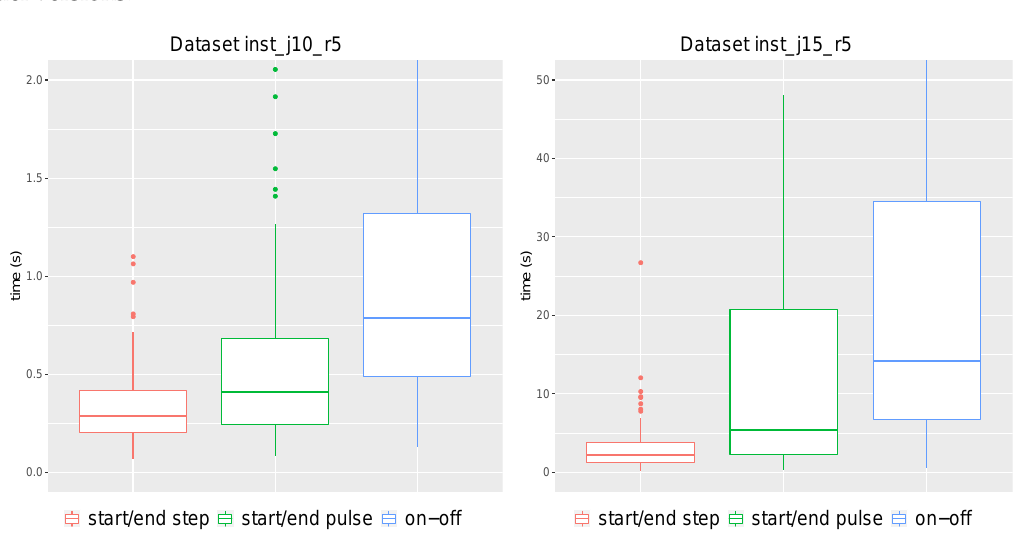
Figure 2. Different model formulation time boxplots for instances of datasets inst _ j 10_ r 5 and inst _ j 15_ r